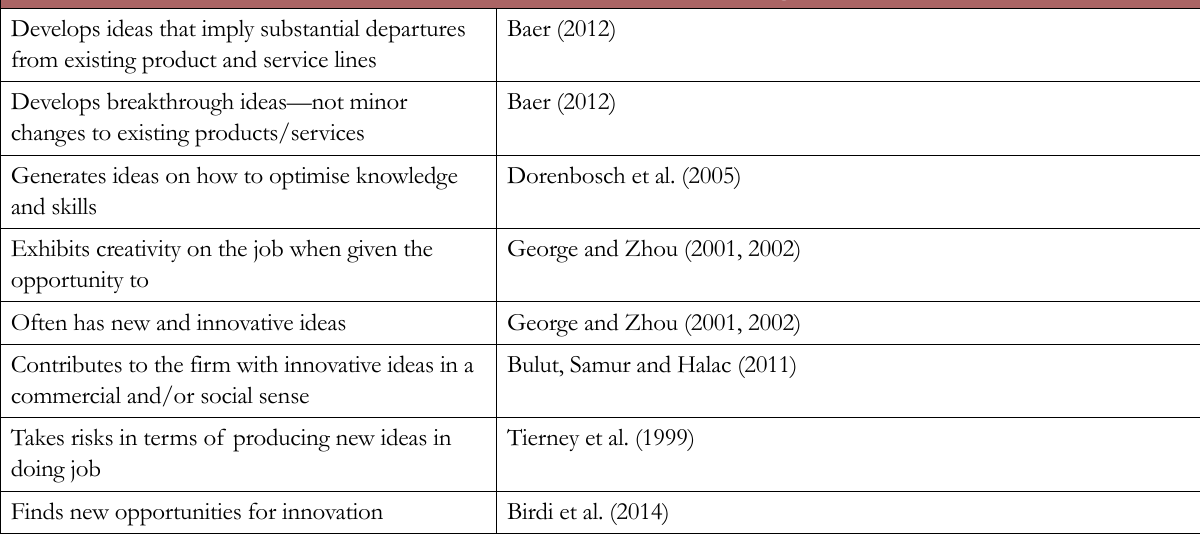
Table 3. Behaviours showing “idea